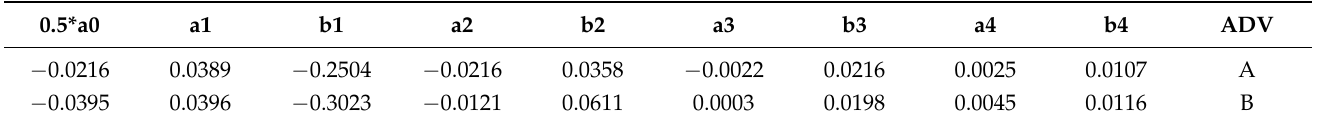
Figure 4. Characteristic records of the along flume particle velocities recorded by ADV A ( left ) and ADV B ( right ). Table 3. Summary of Fourier series coefficients used as an input to numerical model for wave parameters: T = 3.0, Hw = 0.12.